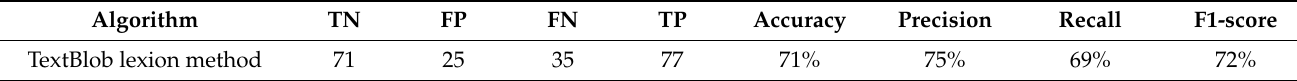
Table 4. Summary of results for testing texblob